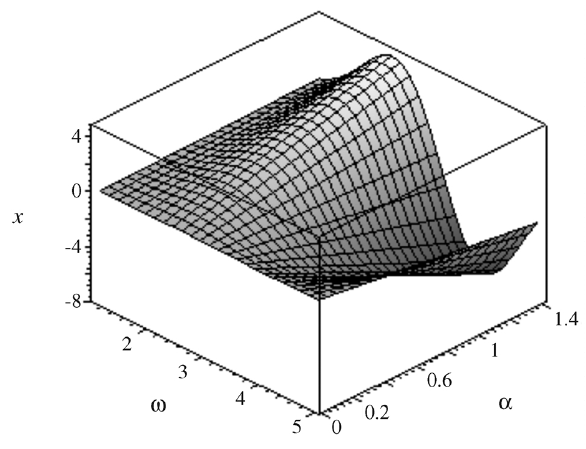
Figure 3 - The squared sum of distances on a candidate for geometric chirality, p = 300.